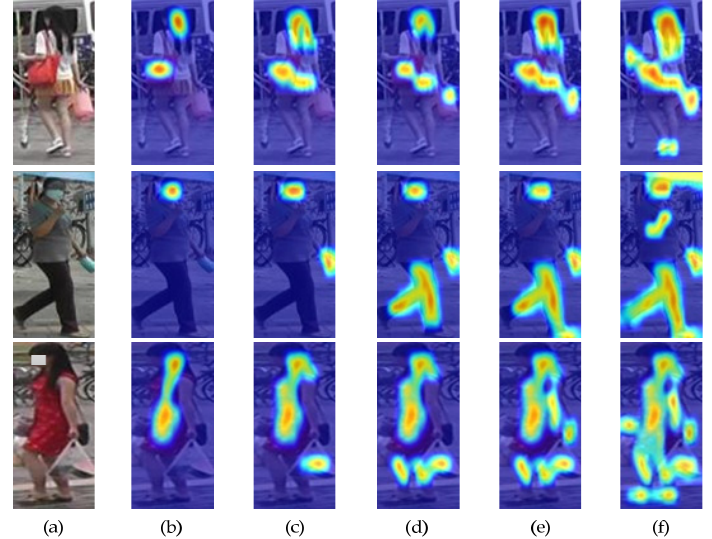
Figure 8. Examples of heat maps of different mechanisms. ( a ) Original person image; ( b ) ResNet50 without attention mechanism; ( c ) ResNet50 + SA; ( d ) ResNet50 + CA; ( e ) ResNet50 + SA + CA; ( f ) ResNet50 + cubic